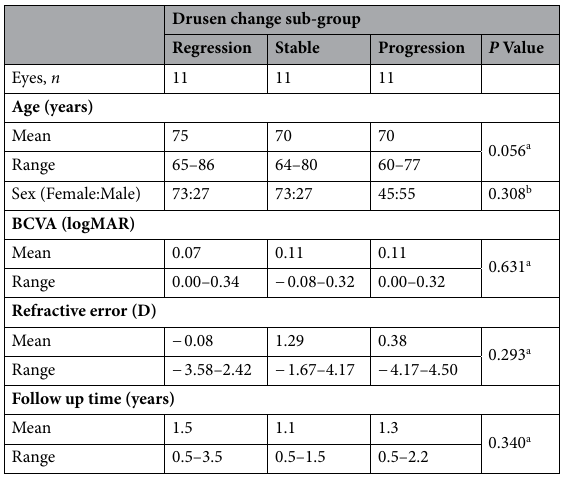
Table 1. Demographics of each drusen change sub-group. Abbreviations: D, diopters. a Analysed using one- way ANOVA. b Analysed using chi-square